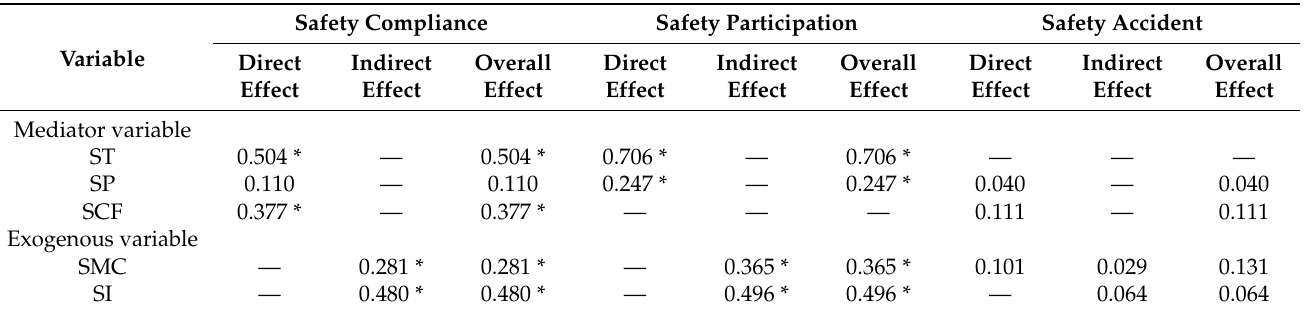
Table 4. The direct, indirect, and overall effects of LSBs on safety